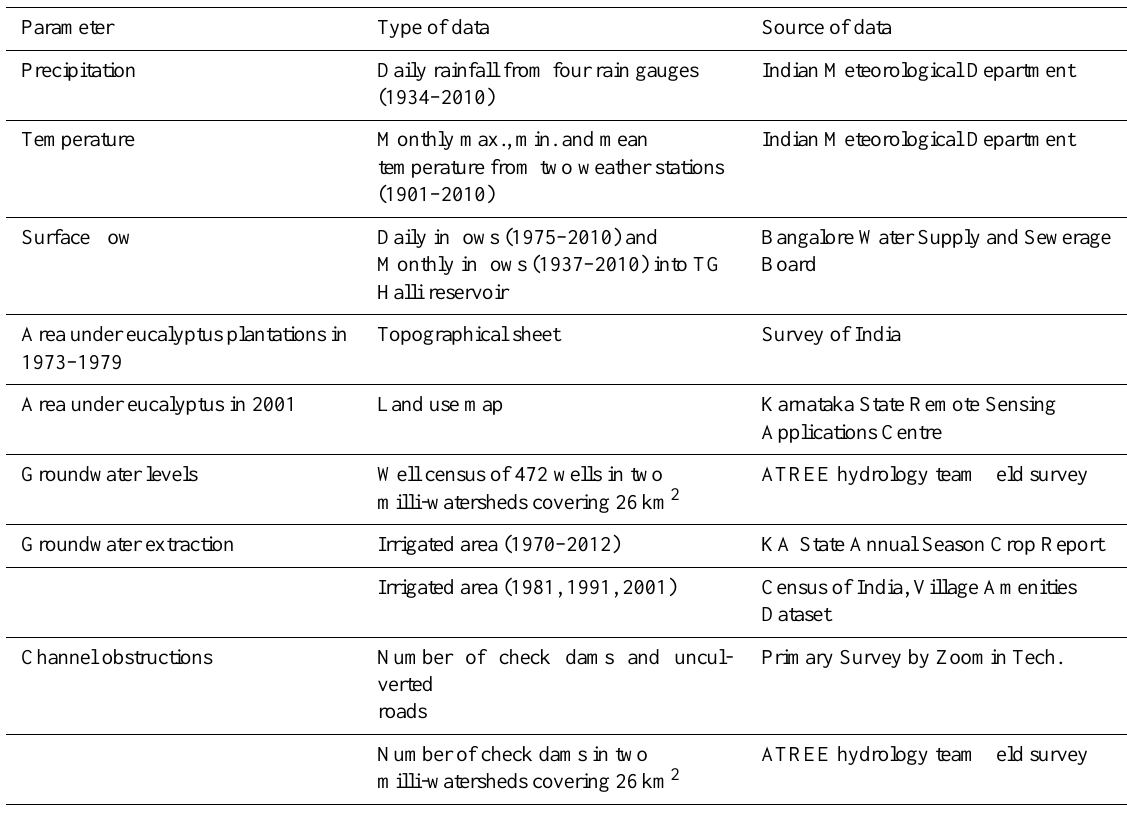
Table 1. Details of various data sets